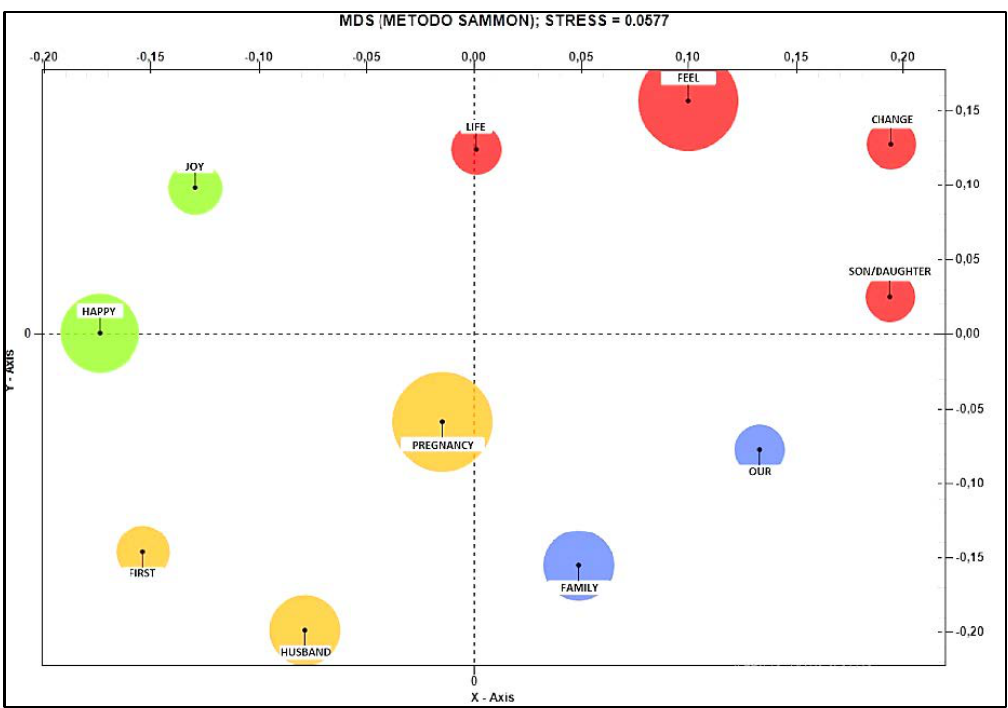
Figure 4. Co- word Analysis referring to the positive/negative positioning of the theme “change”. Figure 4. Co-word Analysis referring to the positive/negative positioning of the theme